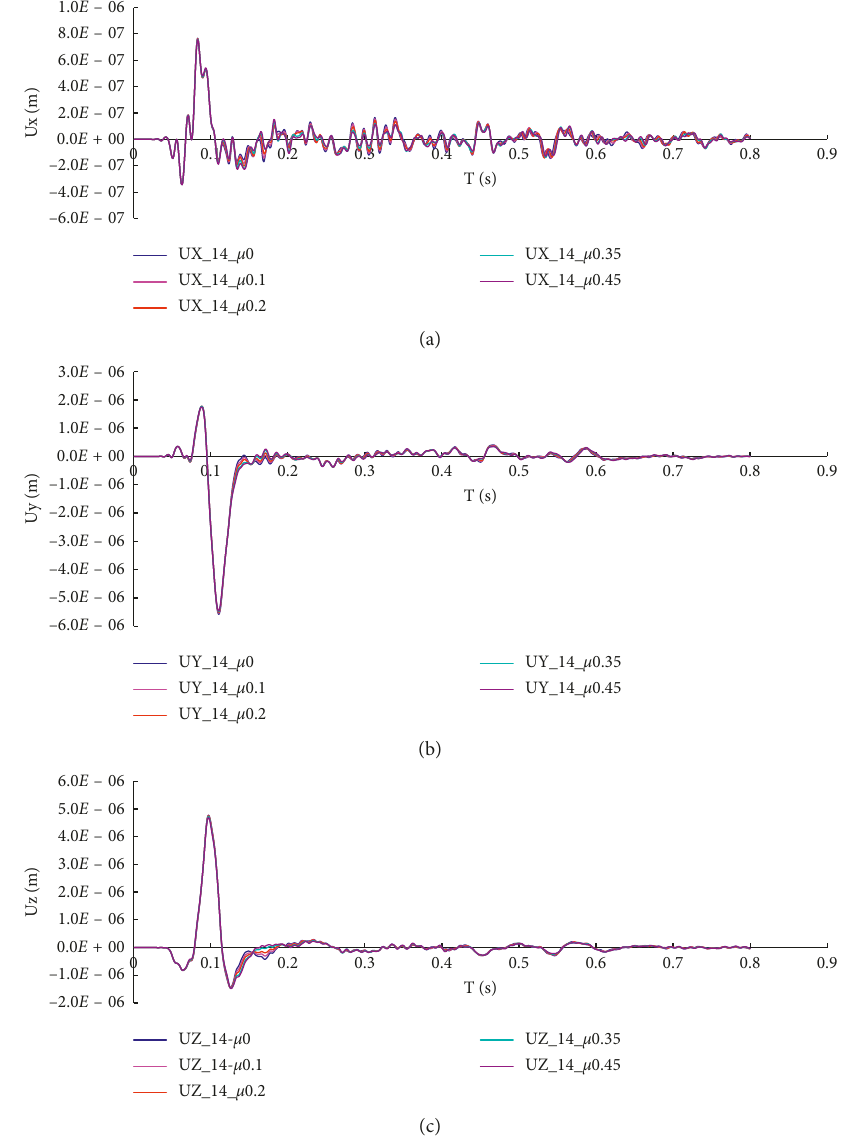
Figure 9: Time-history curve for displacement of No. 8 measuring point on the measuring line of defects in the case of different Poisson’s ratios. (a) X direction. (b) Y direction. (c) Z